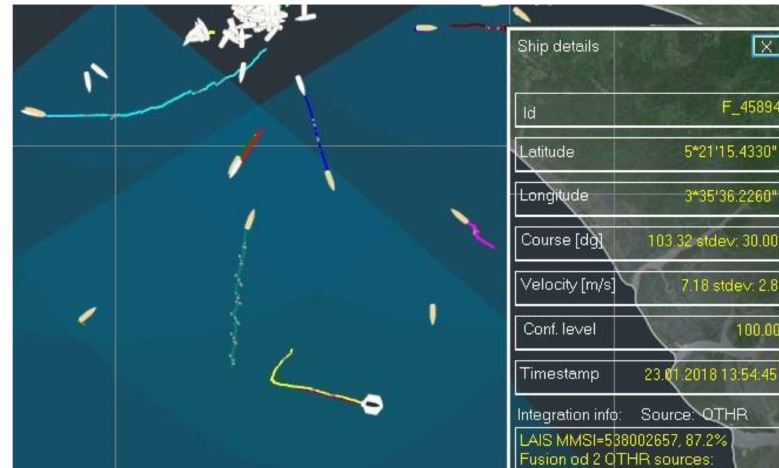
Figure 5. Resolving a “clear situation”—maneuvering target (yellow trace: MRFT data, dark red trace: AIS data).